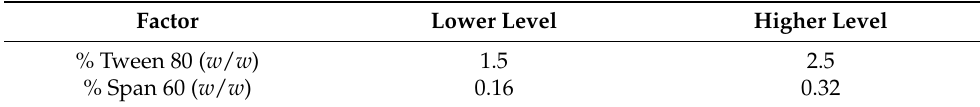
Table 1. Levels studied for the